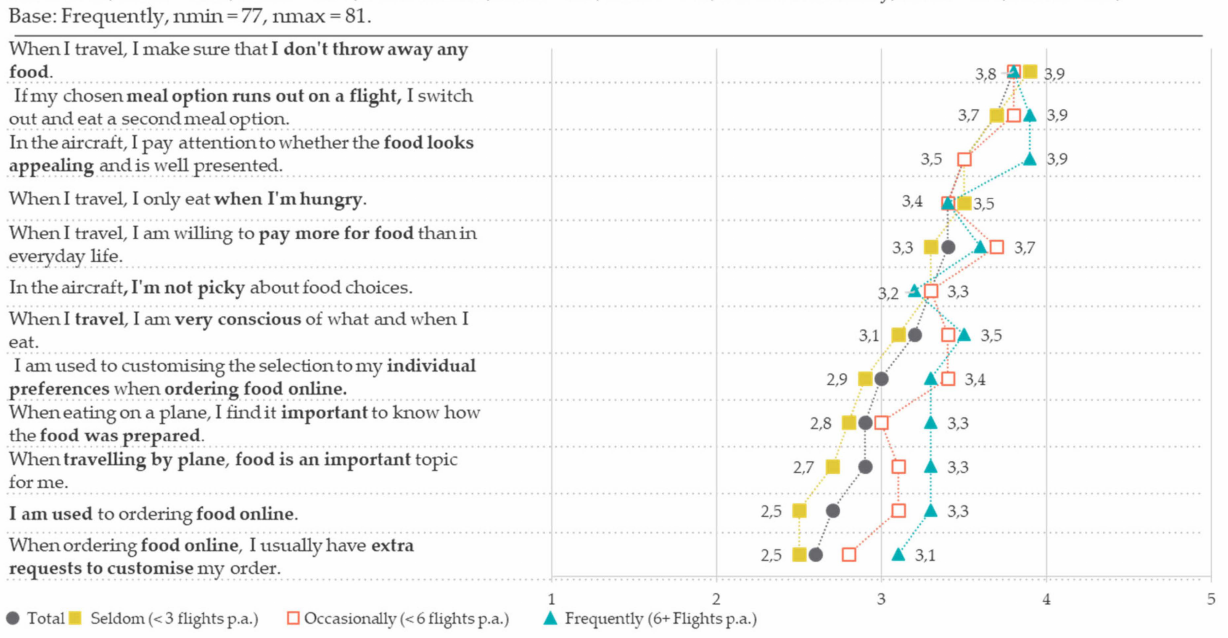
Figure 5. Statements on individuals’ eating behaviour (in Avg.) by flight frequency.